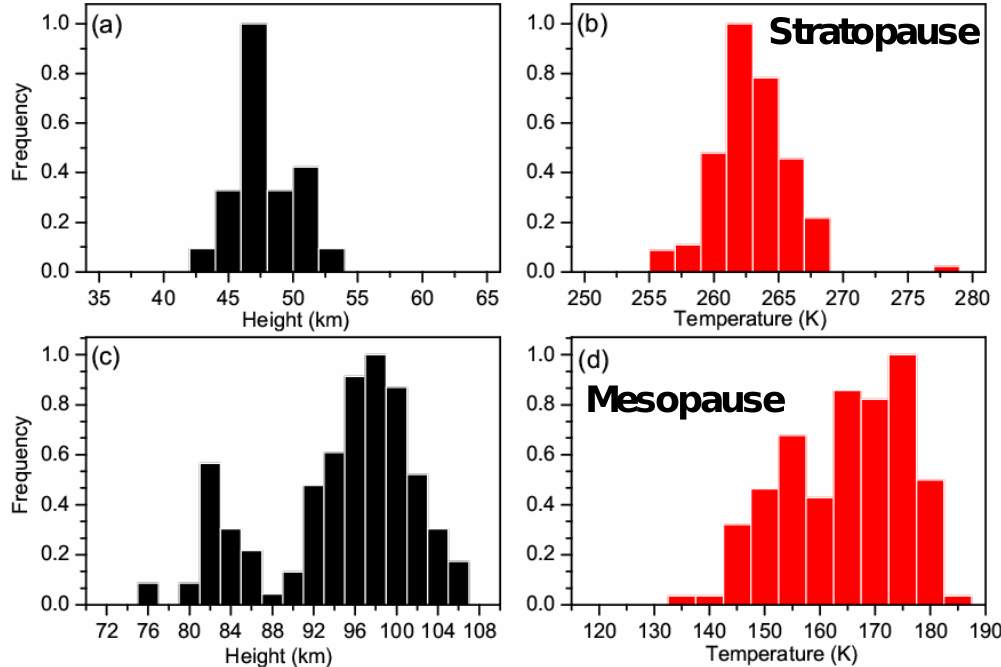
Fig. 7. Normalized distribution of stratopause (a) height and (b) temperature, and mesopause height (c) and temperature (d) observed over Gadanki region during SAFAR pilot campaign (May–November 2008) by SABER/TIMED satellite.